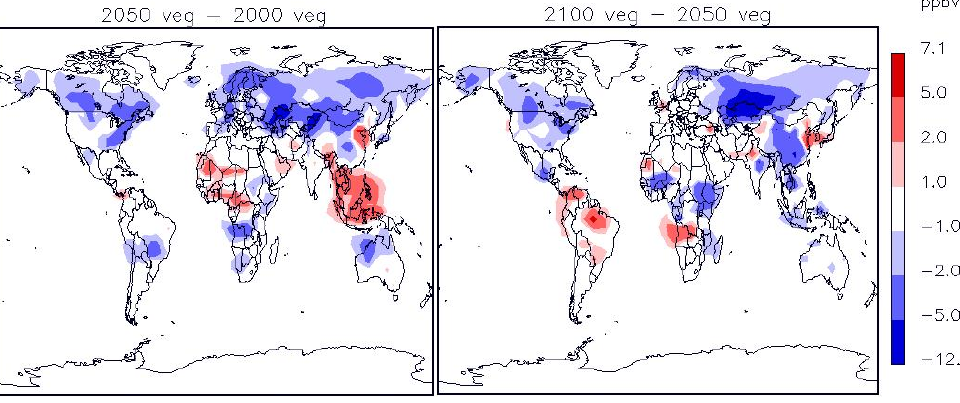
Figure 5. Changes in June-August surface ozone due to vegetation change driven by Fig. 5. Changes in June–August surface ozone due to vegetation change driven by combined effects (changes in climate, CO 2 abundance combined effects (changes in climate, CO 2 abundance and agricultural land use) for the periods and agricultural land use) for the periods of 2000–2050 (left) and 2050–2100 (right). Color scales of 2000-2050 (left) and 2050-2100 (right). Color scales saturate.